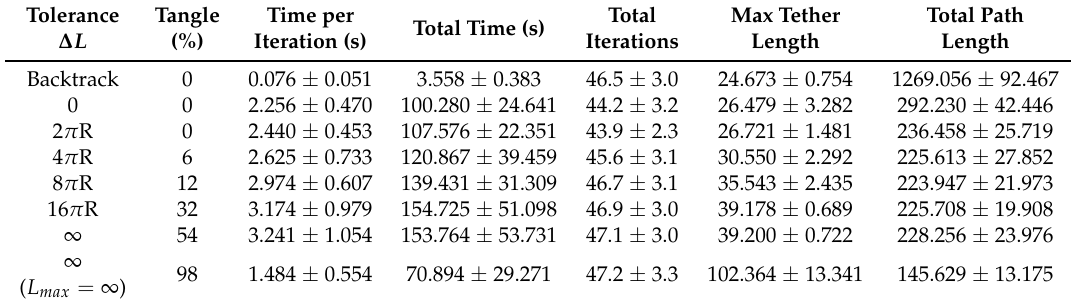
Table 2. Simulation data for high density environment. 20 × 20 map, 0.5 resolution, tether length 40, 50–60 obstacles of radius up to 0.5. Tether base is at [1, 1], and the field of view is set to 4.